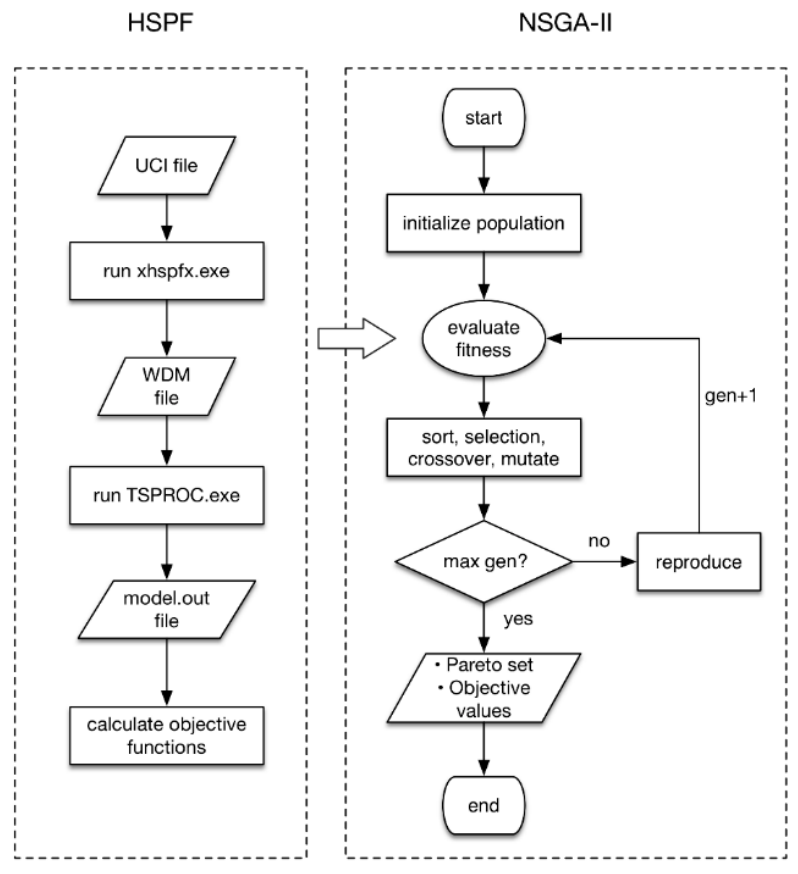
Figure 4. Flowchart of the HSPF/NSGA-II calibration framework.